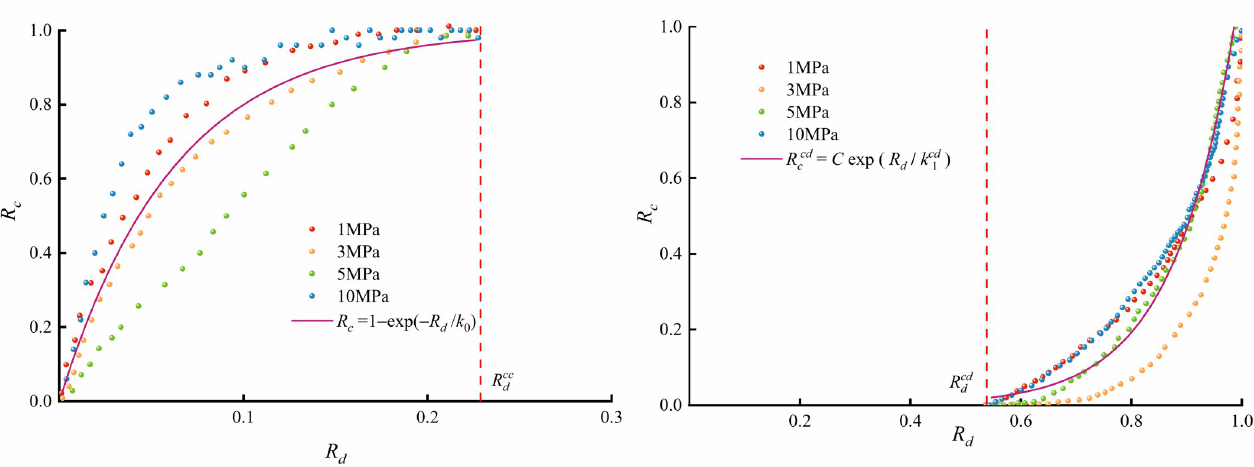
Fig 10. Axial crack strain evolution of micritic bioclastic limestone under triaxial compression tests: (a) initial crack closure stage and (b) new crack growth stage.